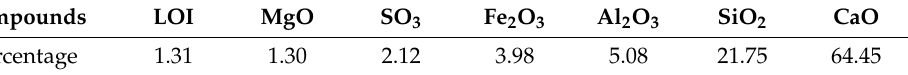
Table 1. Chemical properties of the used cement.